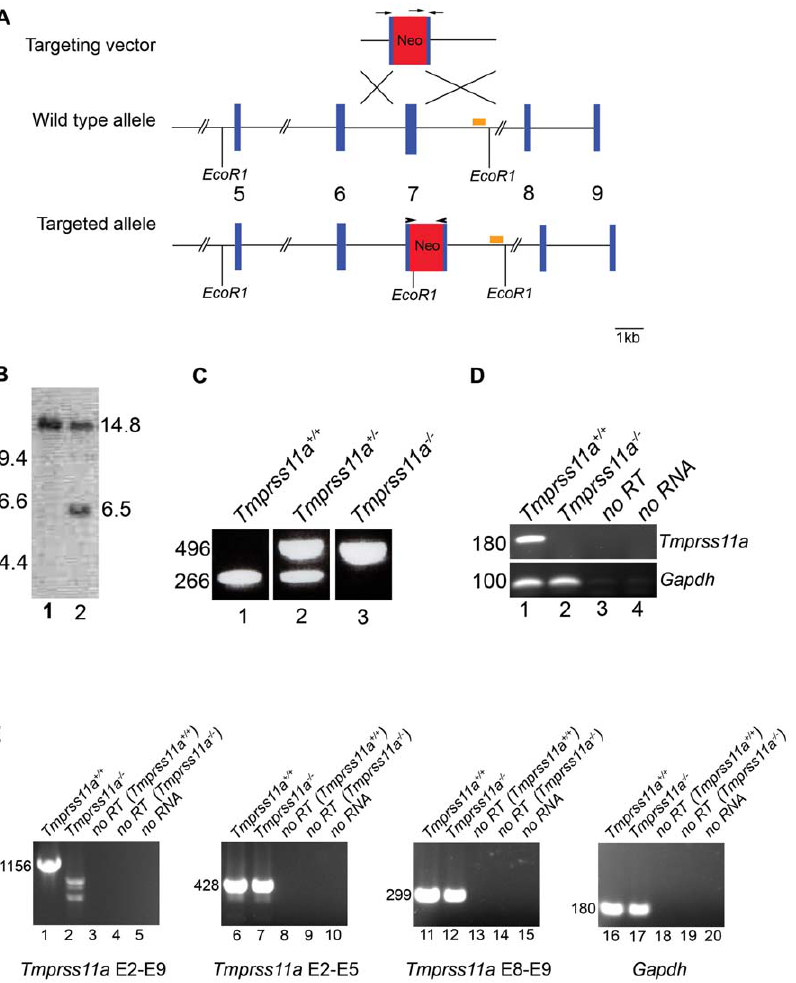
Figure 2. Generation of TMPRSS11A-deficient mice. A. Schematic structure of the gene targeting replacement vector (top), wildtype Tmprss11a gene (middle), and targeted Tmprss11a gene (bottom). Position of Eco RI restriction enzyme cleavage sites used for digestion of genomic DNA for Southern blot analysis, position of Southern blot probe (bar), and positions of primers used for analysis of wildtype and mutant Tmprss11a alleles (arrows) and transcripts (arrowheads) are indicated. B. Southern blot hybridization of Eco-RI digested DNA from a control (lane 1) and a targeted (lane 2) embryonic stem cell clone. The positions of wildtype (14.8 kb) and mutant Tmprss11a (6.5 kb) alleles are indicated on the right. Positions of molecular weight markers (kb) are indicated at left. C. PCR analysis of tail biopsy DNA of offspring from interbred Tmprss11a + / 2 mice. The position of wildtype (496 bp) and mutant Tmprss11a (266 bp) alleles are indicated. D. RT-PCR analysis of Tmprss11a mRNA transcripts from tongue of Tmprss11a + / + (lane 1) and Tmprss11a 2 / 2 (lane 2) mice using the exon 7-flanking primer pair indicated with arrowheads in A. Lanes 3 and 4, no reverse transcriptase and no RNA added to the reactions, respectively. Bottom panel. Amplification of Gapdh mRNA demonstrating the integrity of the cDNA preparation. E. RT-PCR amplication of Tmprss11a mRNA transcripts from tongue of Tmprss11a + / + (lanes 1, 6, 11, and 16) and Tmprss11a 2 / 2 (lane 2, 7, 12, and 17) mice using primer pairs capable of amplifying exons 2–9 (lanes 1–5), 2–5 (lanes 6–10), 8–9 (lanes 11–15), and Gapdh (lanes 16–20). Reverse transcriptase was omitted from the reactions in lanes 3, 4, 8, 9, 13, 14, 18, and 19. No RNA was added to reactions in lanes 5, 10, 15 and 20. Transcript size is indicated left.